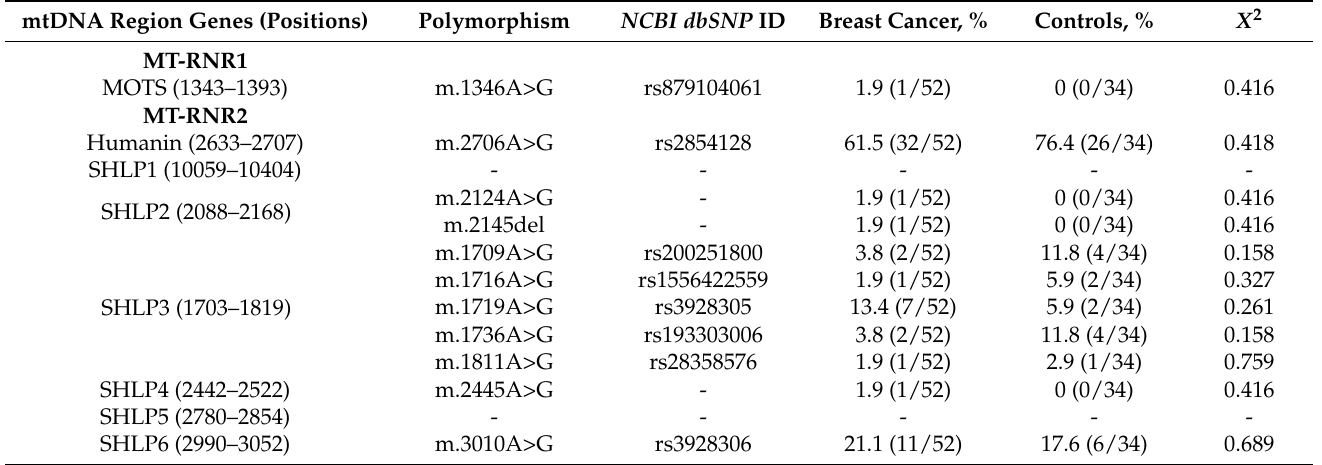
Table 2. Polymorphisms in mitochondrial-derived protein sequences related to breast cancer cases and the